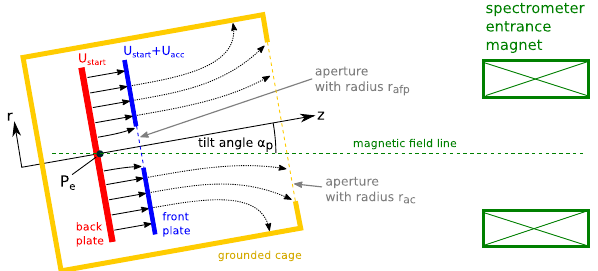
Fig. 2 Schematicdrawingoftheelectronsource.Theelectronsarecre- ated by photo-emission from a thin photocathode layer and accelerated non-adiabatically by a strong electric field ( solid arrows ) inside a rota- tionally symmetric plate-capacitor setup. The grounded cage shields the electric acceleration field at the photocathode from outside influ- ences. The electric field between front plate and grounded cage ( dashed arrows )furtheracceleratestheelectronstotheirnominalkineticenergy. The complete setup can be tilted against the direction of the magnetic field to imprint a defined pitch angle on the generated